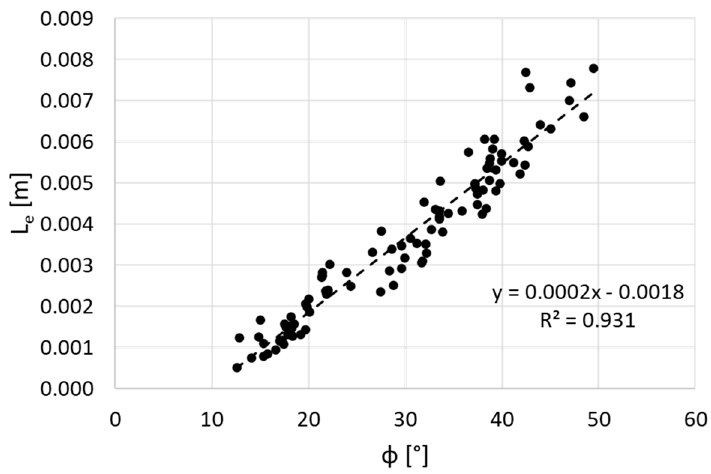
Figure 6. Linear trend of the error in predicting the back extensor muscle moment arm by using φ with respect to the degree of trunk flexion ( φ ).